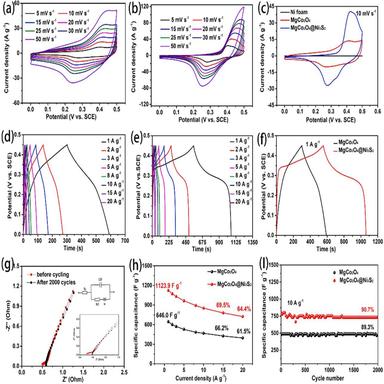
CV curves of (a) MCO and (b) MCO@NS electrodes under different scanning rates. (c) CV curves of the MCO@NS, MCO electrodes and pure Ni foam at 10 mv s − 1 scanning rate. (d) MCO and (e) MCO@NS electrodes' charge–discharge curves under different current densities. (f) MCO@NS and MCO electrodes' Galvanostatic charge–discharge curves at 1 A g− 1 current density. (g) EIS of MCO@NS electrodes before and after 2000 cycle, inset: magnification of the impedance spectra's high-frequency region. (h) Current density d